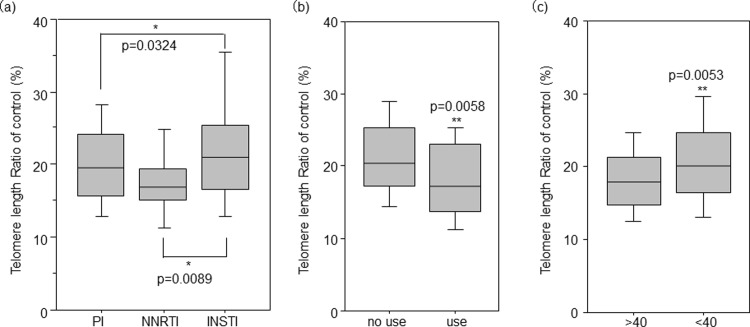
Factors associated with LTL in HIV+ individuals.LTL was measured using real-time quantitative PCR and expressed as a ratio to a housekeeping gene (T/S ratio). Data shown are normalized to an internal control. Differences in LTL are shown between (a) individuals treated with different cART regimens, (b) individuals with (use) or without (no use) a past history of substance use (cannabis, amphetamines, legal intoxicants, and 5-MeO-DIPT), and (c) individuals who achieved plasma HIV viral loads <40 RNA copies/mL (<40) or failed to achieve this level of control (>40) after 1 year of starting cART. * indicates statistical significance with P value obtained from the Bonferroni–Dunn test; ** indicates statistical significance with P value obtained from the Mann-Whitney U-test. Abbreviations: cART, combination antiretroviral therapy; NNRTI, nonnucleoside reverse transcriptase inhibitor; PI, protease inhibitor, INSTI, integrase strand transfer inhibitor.